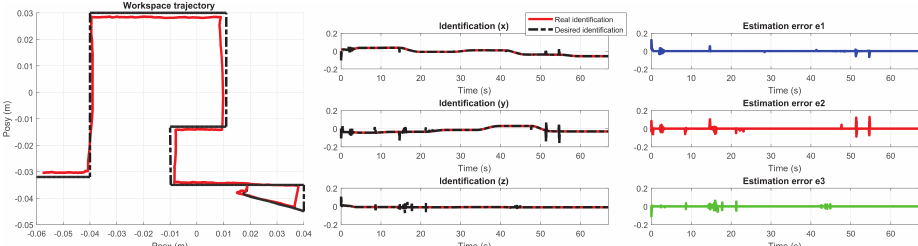
Figure 31. Performance PID wavenet-IIR controller for exercise 1. In this case, the robot was used for σ = r (right